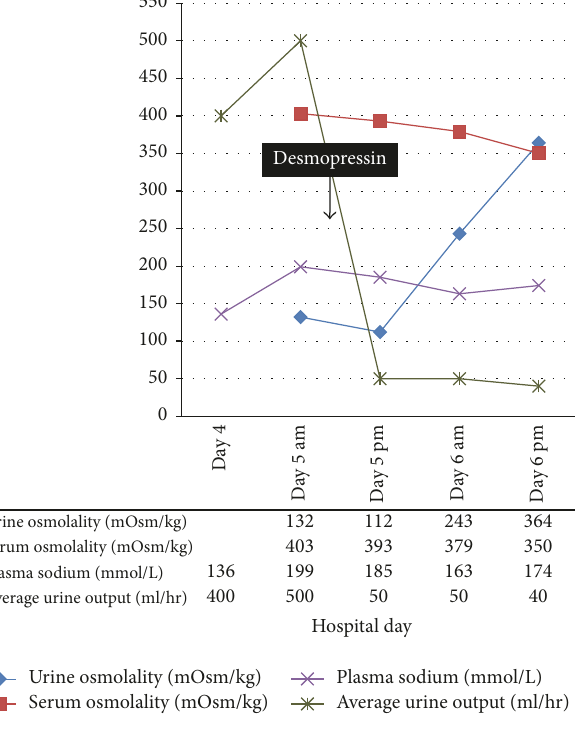
Figure 1: Changes in plasma sodium, plasma and urine osmolality, and urine output before and after